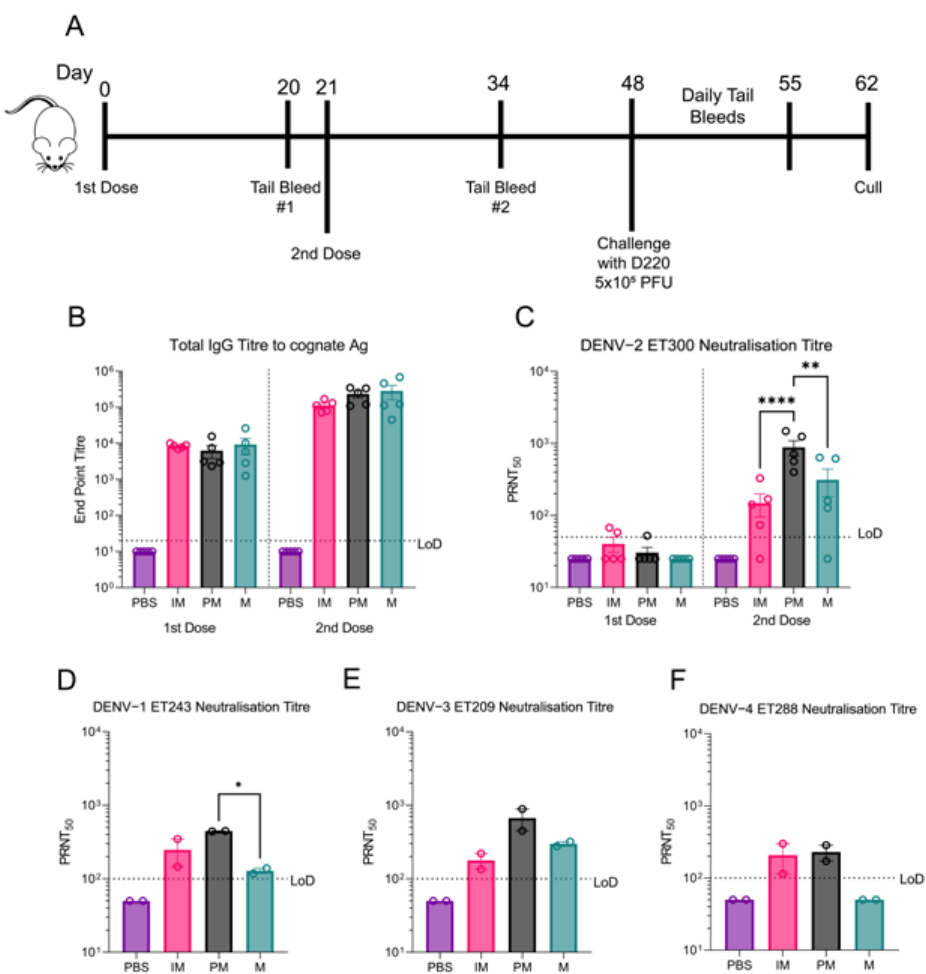
Figure 2. Immunogenicity of bDENV-2 in AG129 mice. ( A ) Vaccination and challenge schedule of AG129 mice with bDENV-2 and DENV-2 D220, respectively. ( B ) Total IgG titres to cognate antigen (Ag) from tail bleeds after one and two doses of bDENV-2 vaccination, as determined by indirect ELISA. End-point titre of mouse sera to cognate antigen corresponding to the reciprocal of the highest dilution that has an O.D above the mean + three standard deviations of the no sera wells on each plate. ( C ) PRNT 50 titre of individual mouse serum against DENV-2 ET300 with error bars displaying the standard error of the mean (SEM). Neutralizing antibody titre (PRNT 50 ) of pooled mice sera against DENV-1 ET243 ( D ), DENV3 ET209 ( E ), and DENV-4 ET288 ( F ). Each symbol represents a technical replicate ( n = 2) of pooled mice sera with error bars displaying the SEM. Dotted line indicates lower limit of detection (LoD). Significance was determined using an ordinary one-way ANOVA with Tukey’s multiple comparisons test on GraphPad Prism 9.0. **** p < 0.0001, ** p ≤ 0.002, * p ≤ 0.03, ns p ≥